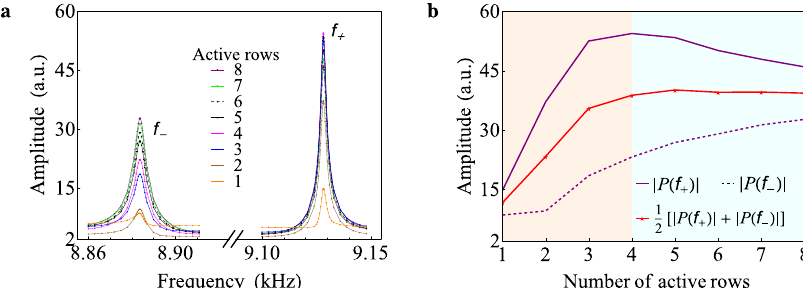
Fig. 3 Whispering gallery gain saturation. a Computed chiral WG mode spectra using the MST for an increasing number of active rows in each insulator region. The plotted range displays an activation, from 12.5% to 100%, of all involved cylinders of the WG sonic lattice. b The average of the two chiral WG mode-amplitudes, i.e., j P f (cid:3) ð Þj and j P f þ ð Þj , displays gain saturation from the onset of four active row, i.e., eight total